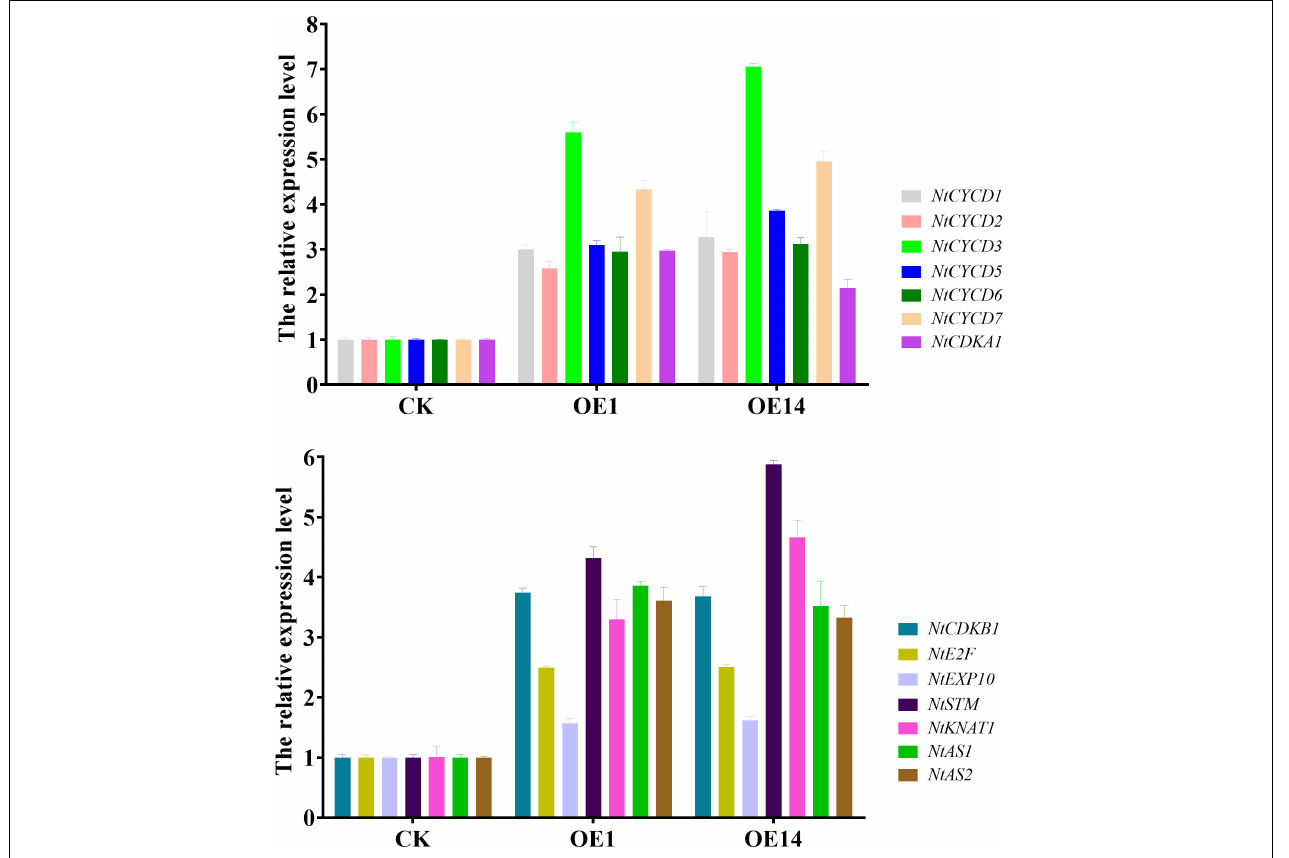
FIGURE 7 | Quantitative real-time PCR analysis of endogenous related genes in CK and transgenic tobacco. CK, empty vector control tobacco; OE1/14, two individual transgenic